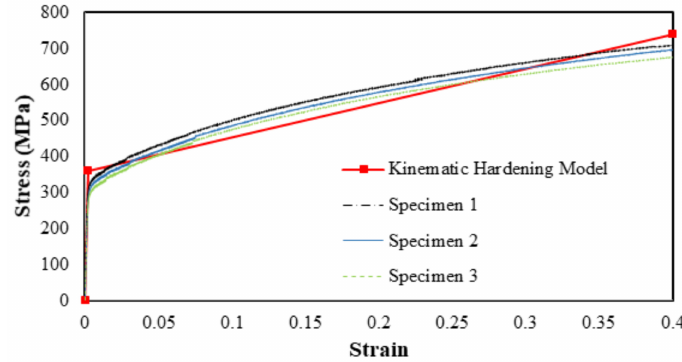
Figure 3. Stress–strain relationships of STS 304